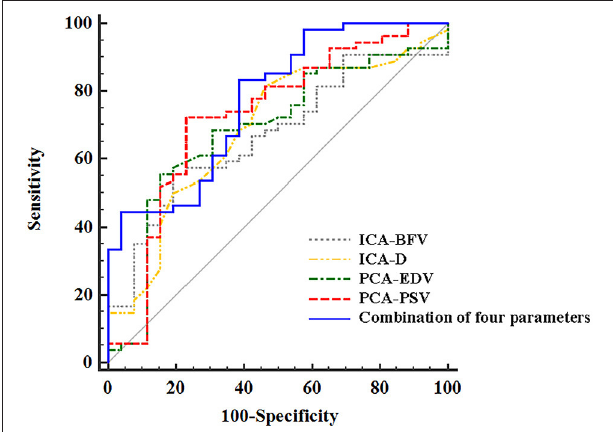
FIGURE 6 | The ROC curves of ultrasound parameters to distinguish stroke from non-stroke patients with MMD. The area under the ROC curves was 0.688 (95% CI, 0.575, 0.787) for the D of EICA, 0.670 (95% CI, 0.556, 0.771) for the FV of EICA, 0.727(95% CI, 0.616, 0.821) for the PSV of PCA, 0.684 (95% CI, 0.571, 0.784) for the EDV of PCA, and 0.772(95% CI, 0.665, 0.858) for the combination of the four parameters. ROC, receiver operating characteristic; MMD, moyamoya disease; EICA-D, diameter of the extracranial internal carotid artery; EICA-FV, flow volume of the extracranial internal carotid artery; PCA-PSV, peak systolic velocity of the posterior cerebral artery; PCA-EDV, end diastolic velocity of the posterior cerebral